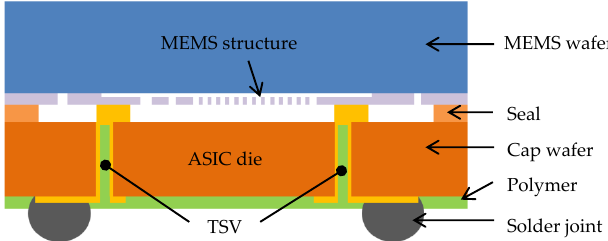
Figure 1. Schematic cross-section image of the MEMS sensor with TSVs through the CMOS IC die. MEMS sensors using TSVs allow significant package size reduction and cost savings.